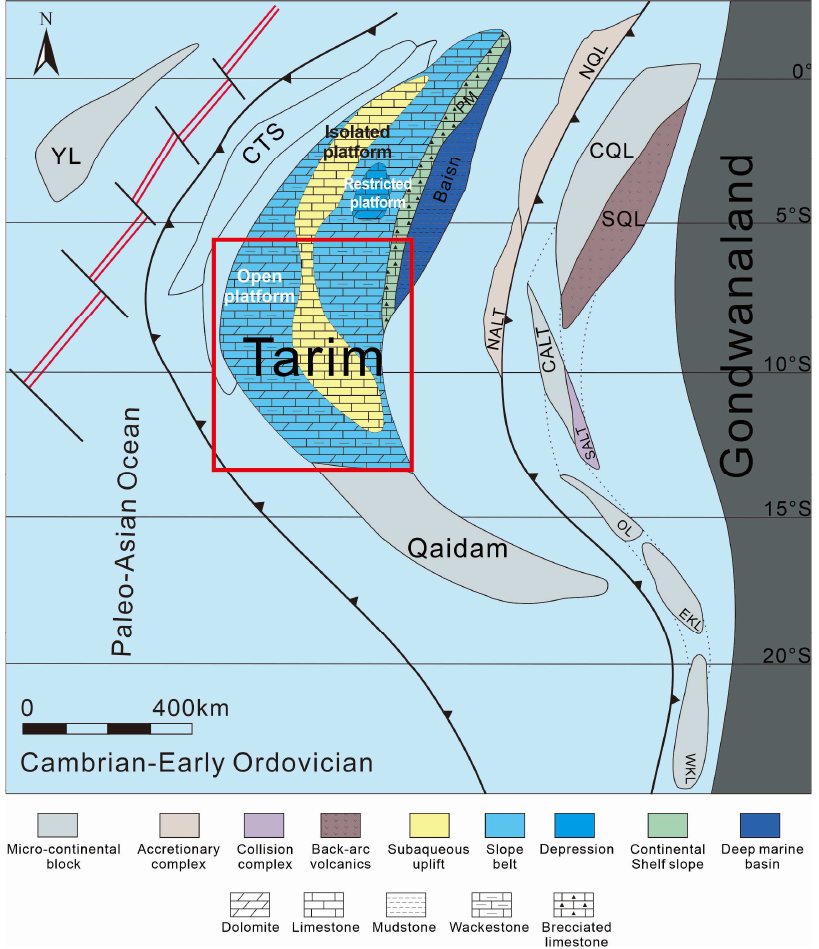
Figure 7. Tectonic and paleogeographic evolution of Tarim and its abbreviations of micro-continental blocks: NQL = North Qilian; CQL = Central Qilian; SQL = South Qilian; NALT = North Altyn; CALT = Central Altyn; SALT = South Altyn; WKL = West Kunlun; EKL = East Kunlun; OL = Oulongbuluke; CTS = Central Tianshan [56].